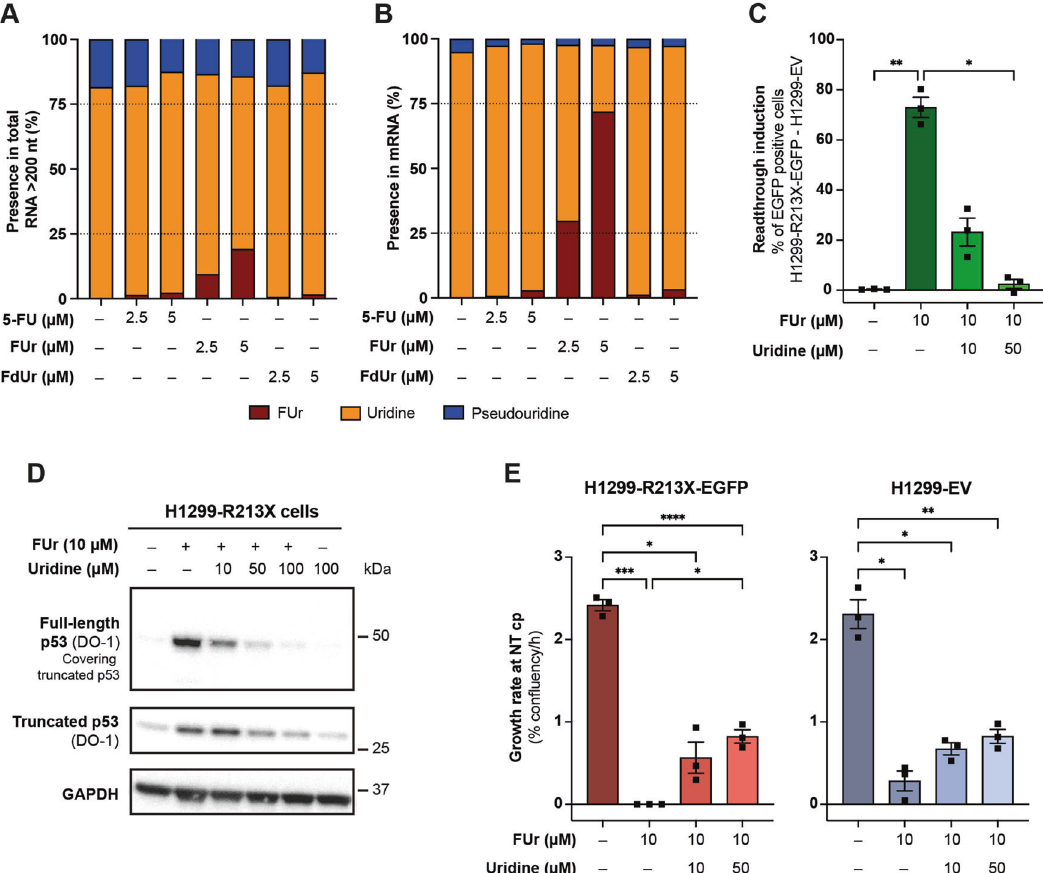
Fig. 6 FUr is ef fi ciently incorporated into mRNA. A , Content of FUr, uridine and pseudouridine as percentage of total content of FUr, uridine and pseudouridine after 5-FU, FUr or FdUr treatment for 3 days in total RNA species longer than 200 nucleotides (nt) and B , in mRNA. C , Flow cytometry analysis of readthrough induction after 10 µM FUr treatment alone or in combination with 10 or 50 µM uridine for 72 h. Readthrough induction was assessed by percentage of EGFP positive H1299-R213X-EGFP cells (EGFP positive cells in H1299-EV control cells were subtracted), N = 3. Note that results were obtained in two of the experiments presented in Fig. S6A, so values for two non-treated samples (NT) are the same in both fi gures. D , Western blot analysis of H1299-R213X cells treated with 10 µM FUr alone or in combination with 10, 50 or 100 µM uridine or 100 µM uridine alone for 72 h. Full membrane was incubated with DO-1 antibody to visualize truncated p53. Truncated p53 was then covered and the membrane was exposed again to show full-length p53 bands. Membrane was cut and blotted with GAPDH, which was used as loading control. E , Cell growth rate of H1299-R213X-EGFP or H1299-EV cells untreated or treated with 10 µM FUr alone or in combination with 10 or 50 µM uridine was monitored up to 72 h with Incucyte ® S3 system. Data are presented as cell growth rate in percentage of con fl uency per hour when growth rate of the non-treated cell population (-) reaches its maximum or critical point (cp), N = 3. Note that results were obtained in two of the experiments presented in Fig. S6B, and so values for two non-treated samples (NT) are the same in both fi gures. In C and E , data are represented as mean ± SEM. Statistical analyses for each panel were performed comparing all conditions to each other using repeated measures one-way ANOVA followed by Tukey ’ s multiple comparisons test (* p ≤ 0.05, ** p ≤ 0.01, *** p ≤ 0.001, **** p ≤